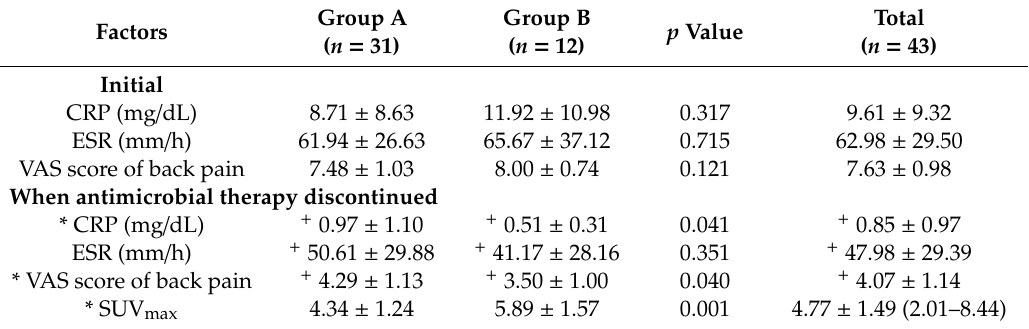
Table 3. Comparison of clinical and radiological features between the groups A and B.